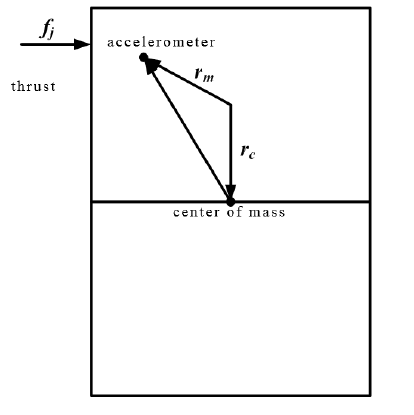
Figure 1. The distribution diagram of spacecraft